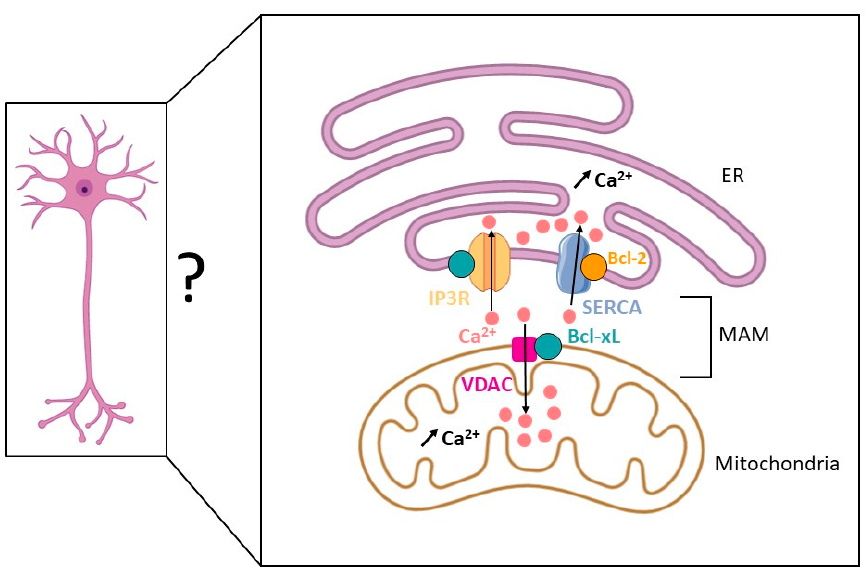
Figure 2. A fraction of Bcl-2 and Bcl-xL is located at the mitochondria-associated-endoplasmic reticulum membranes (MAM) to favor Ca 2+ storage in the endoplasmic reticulum (ER) and the mitochondria. By interacting with the sarco/endoplasmic reticulum Ca 2+ ATPase (SERCA) and inositol 1,4,5-triphosphate receptors (IP3Rs), Bcl-2 and Bcl-xL promote ER Ca 2+ uptake. By interacting with voltage-dependent anion channel (VDAC), Bcl-xL promotes mitochondria Ca 2+ uptake. Thus, Bcl-xL appears to play a key role in Ca 2+ distribution at the MAM. Given the importance of Ca 2+ dynamics in neurons, Bcl-xL contribution to Ca 2+ homeostasis may be critical in the central nervous system (CNS).